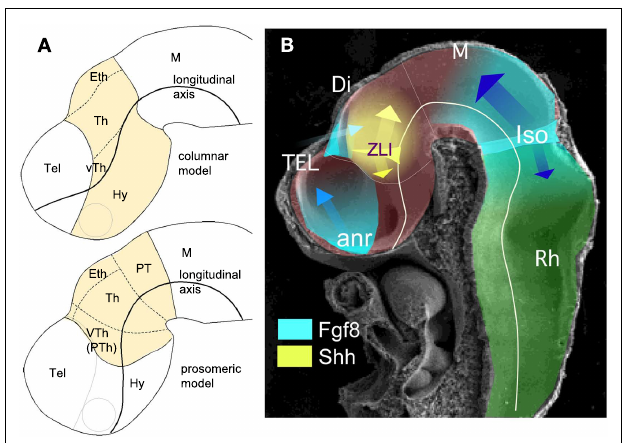
FIGURE 1 | (A) Schematic representations of a lateral view of E10.5 mouse neural tube where diencephalic territories (yellow) have been represented following columnar (above) and prosomeric (below) models. (B) Scanning electron microscope image showing a lateral view of E10.5 mouse neural tube where the main neural segments and planar secondary organizers are represented. Abbreviations: anr, anterior neural ridge; Di, diencephalon; Eth, epithalamus; Hy, hypothalamus; IsO, isthmic organizer; M, mesencephalon; PT, pretectum; Rh, rhombencephalon;Tel, telencephalon;Th,